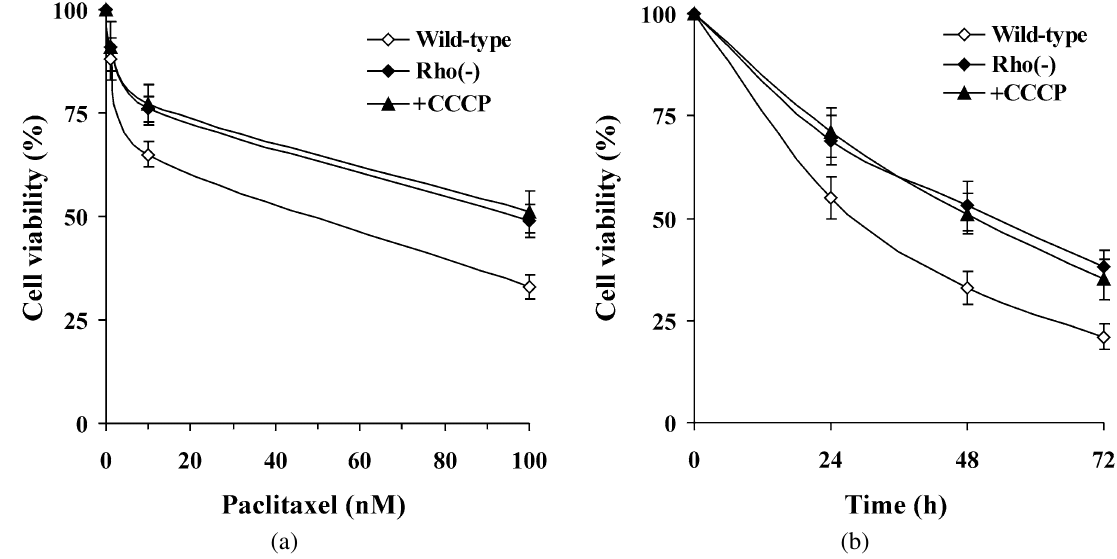
Fig. 6. MtDNA depletion reduces chemosensitivity to paclitaxel and PARP-1 protein levels in LNCaP prostate cancer cells. (a) Shows the dose-response curves of wild-type, Rho( − ) and CCCP-treated LNCaP cells after exposure to paclitaxel at three different concentrations (1 nM, 10 nM and 100 nM) for 24 h. Viable cells were measured by MTT assay and expressed as a percentage of the controls. (b) Shows the time-response curves of wild-type, Rho( − ) and CCCP-treated LNCaP cells in presence of 10 nM paclitaxel for 24, 48 and 72 h. Data represent mean ± S.E. of three independent